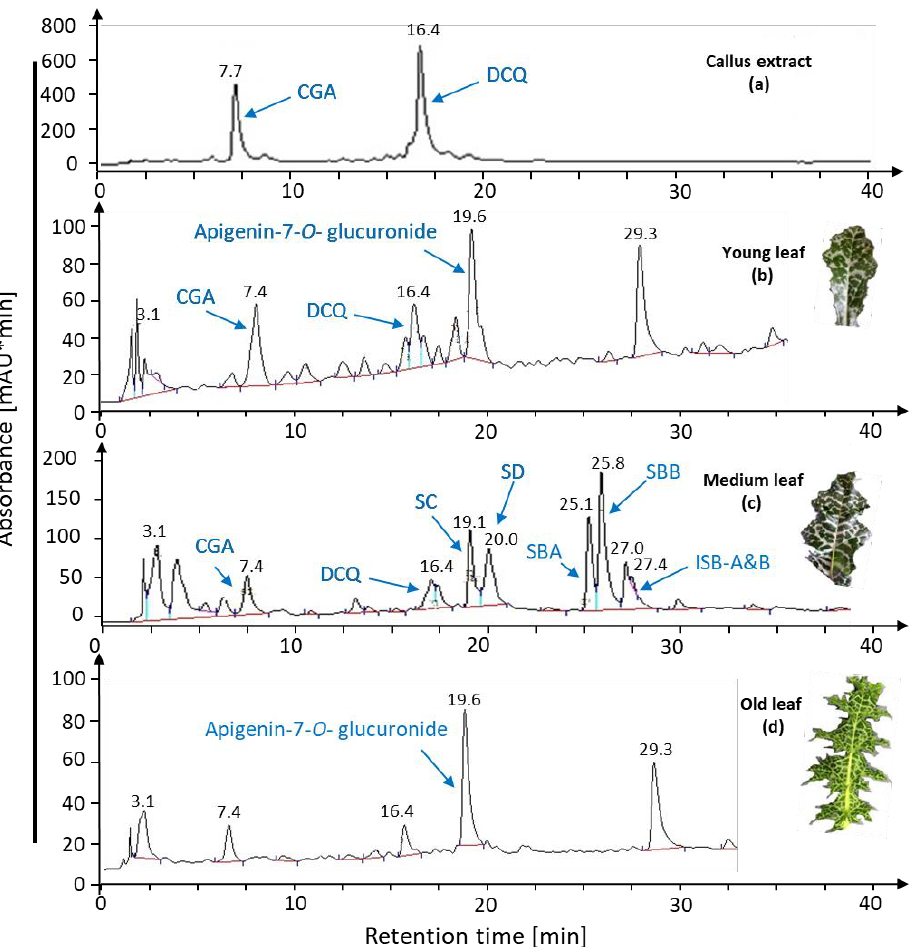
Figure 5. HPLC chromatograms of bioconversion assays with young, medium, and old leaves. The callus extract shown in ( a ) was exposed to leaf discs of young ( b ), medium ( c ), and old ( d ). Leaves from greenhouse-grown S. marianum . Data are representative for six independent experiments.